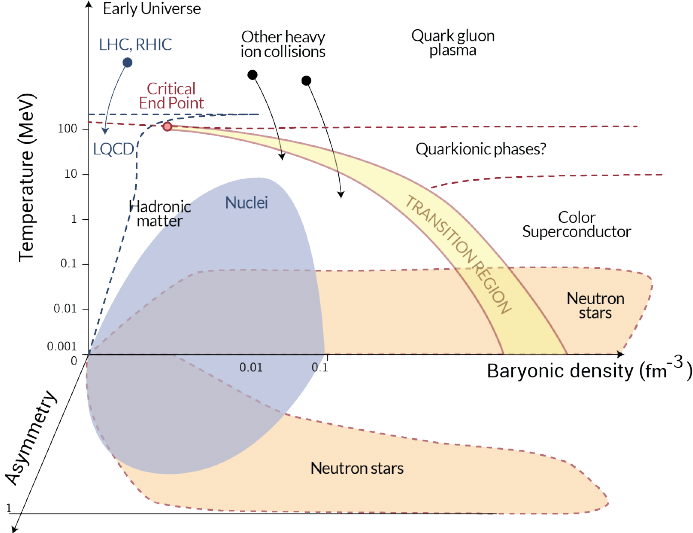
Figure 1. QCD phase diagram. On the left of the transition region stands hadronic matter and on the right side, the quark gluon plasma. Quarkyonic phases represent a region where chiral symmetry has been restored but matter is still confined. Figure taken and adapted from